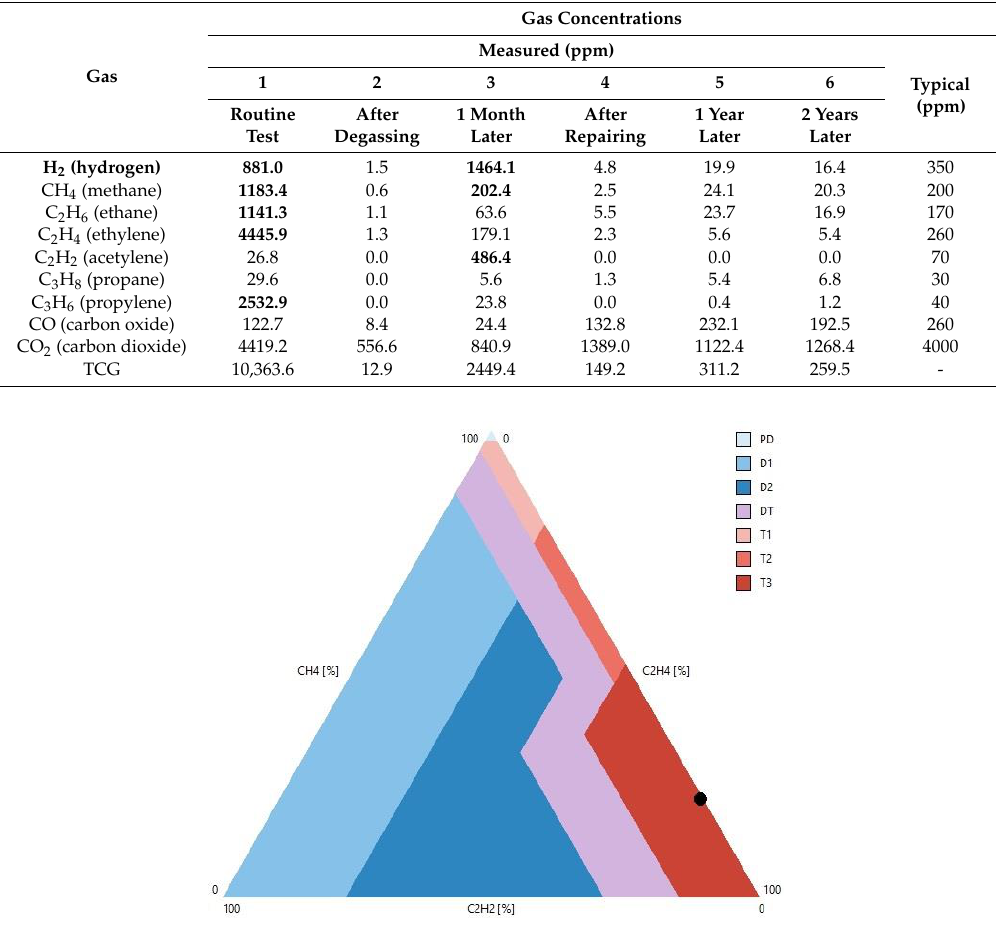
Figure 11. Defect indicated by the Duval Triangle Method for a 2.7 MVA, 30/0.66 kV power transformer for a 1st measurement designated as “ routine test ” .